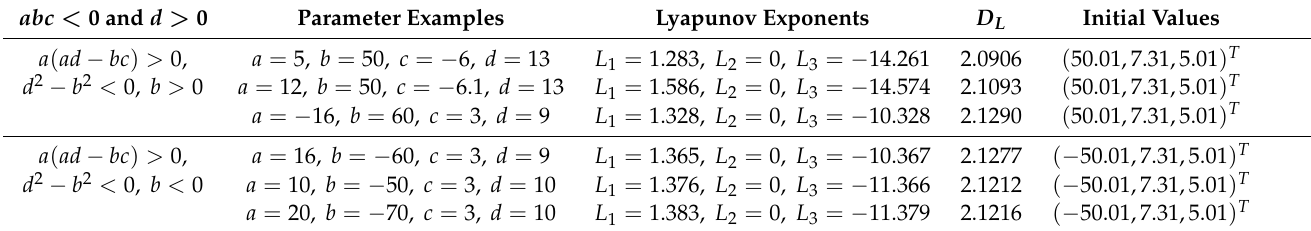
Table 2. Parameter examples and Lyapunov exponents for chaotic system (1) that generate chaos at the equilibrium S 1 .